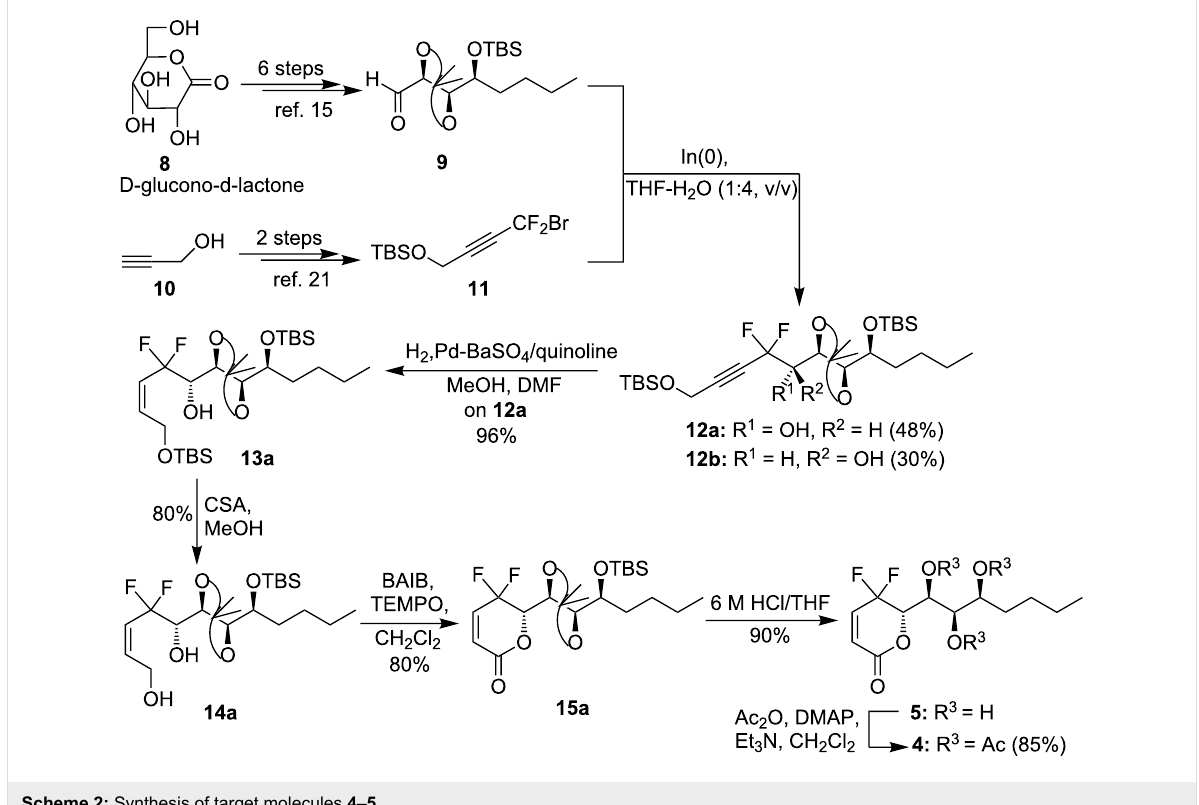
Scheme 2: Synthesis of target molecules 4 – 5 .